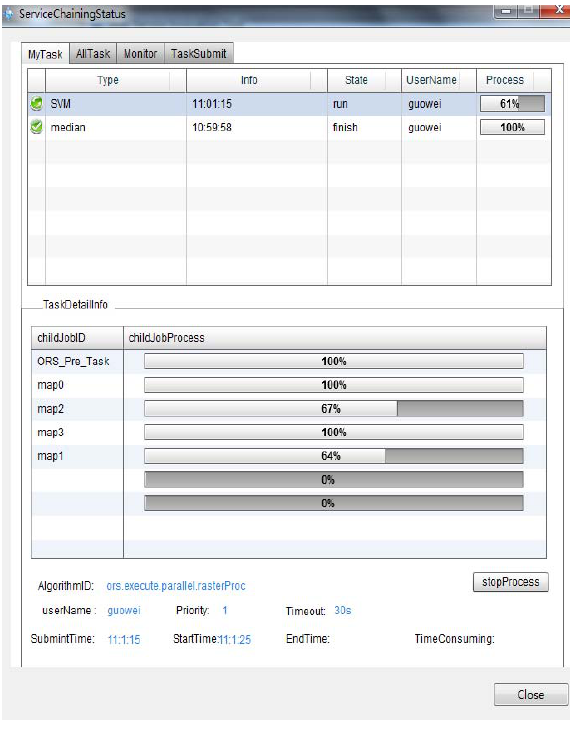
Figure 3. Status Monitor in the